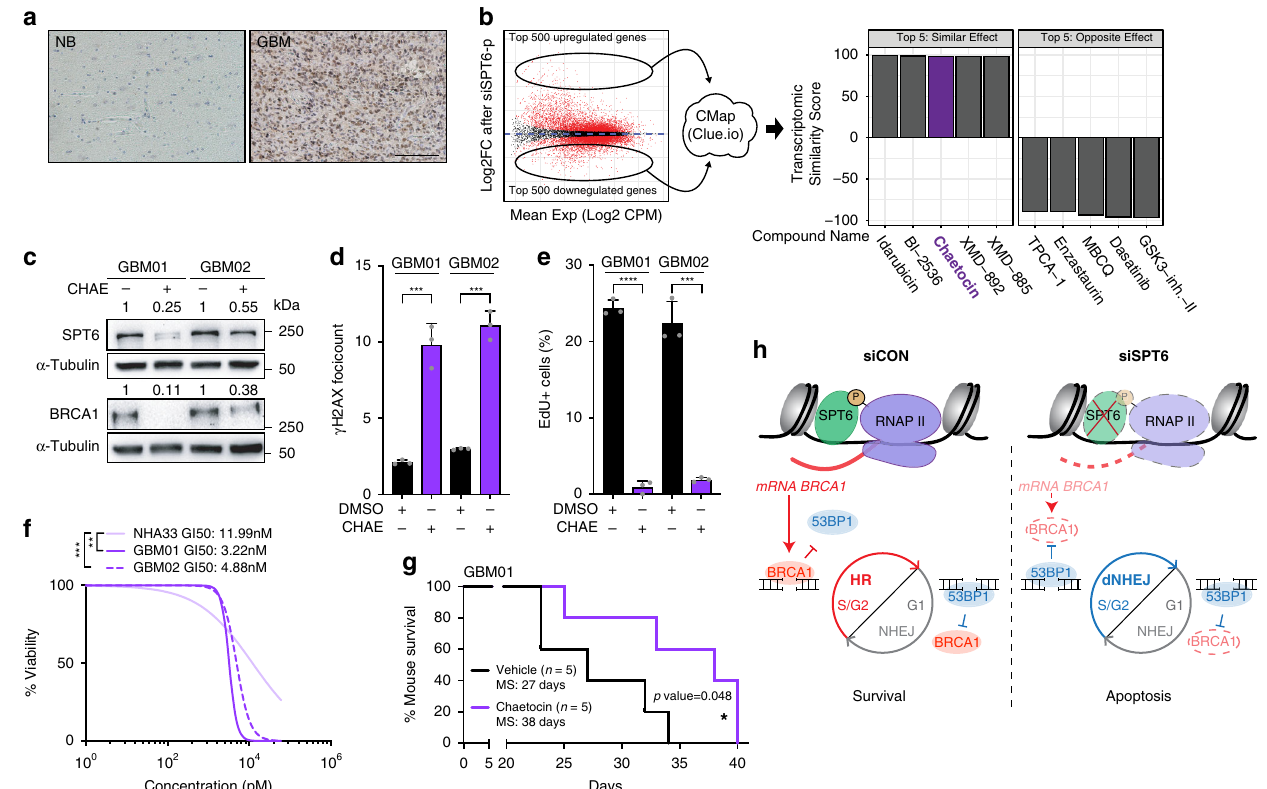
Fig. 7 CMap identi fi es chaetocin as a drug candidate mimicking SPT6 loss in GSCs. a Representative IHC staining of SPT6 in normal brain (NB; n = 10) and GBM ( n = 24). Scale bar 100 μ m. b Schematic representation of the Connectivity Map (CMap) analysis. Top 500 up- and downregulated genes after SPT6-p (pool) silencing was extracted and uploaded to CMap, which generated a list of chemical compounds mimicking SPT6 loss at transcriptional level. c Representative immunoblot analysis of SPT6 and BRCA1 protein levels in GSCs (GBM01 and GBM02) treated with chaetocin (CHAE; 24 h of 30 nM). Loading control: α -Tubulin. d γ H2AX foci quanti fi cation 24 h after exposure to chaetocin (CHAE, 30 nM) in GSCs (GBM01 and GBM02). Data are presented as mean ± s.d. *** p = 0.0007 (GBM01) and *** p = 0.0001; two-tailed unpaired t -test. e Quanti fi cation of EdU positive cells (%) after 24 h